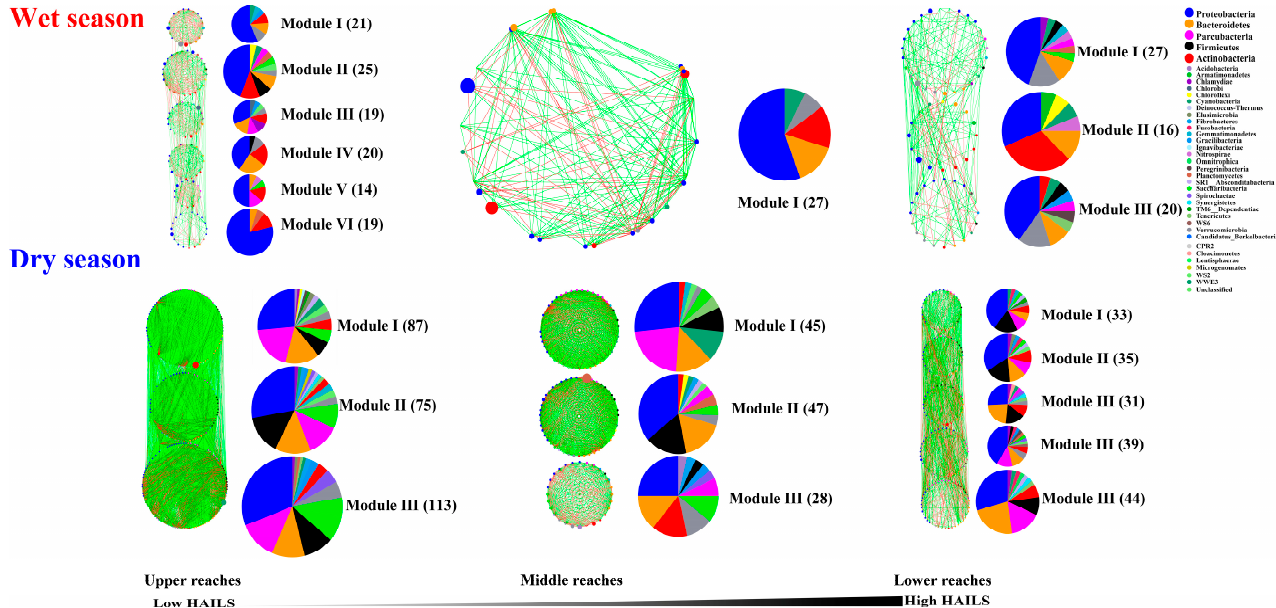
Figure 7. Phylum-level composition of the dominant modules in the bacterioplankton molecular ecological networks in different reaches during the wet and dry season in the Yuan River.